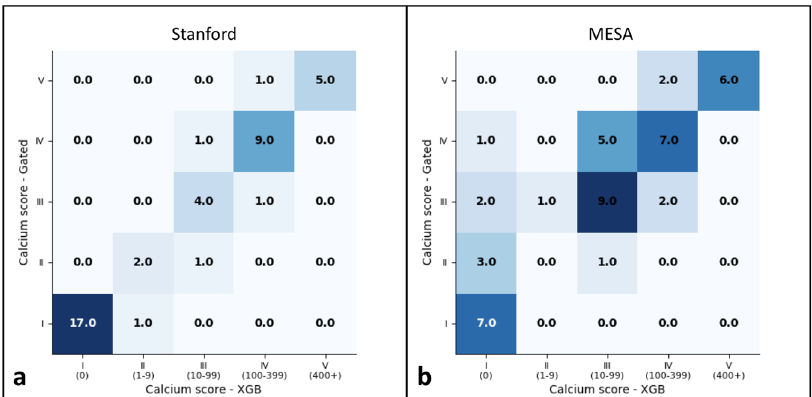
Fig. 5 Comparison of automated and manual CAC scoring on non-gated chest CT exams using internal and MESA datasets. Confusion matrices for Stanford ( a ) and MESA ( b ) test sets comparing automated scoring non-gated chest CT exams to ground truth scores. Ground truth scores are on the y -axis and model prediction are on the x -axis of each matrix.